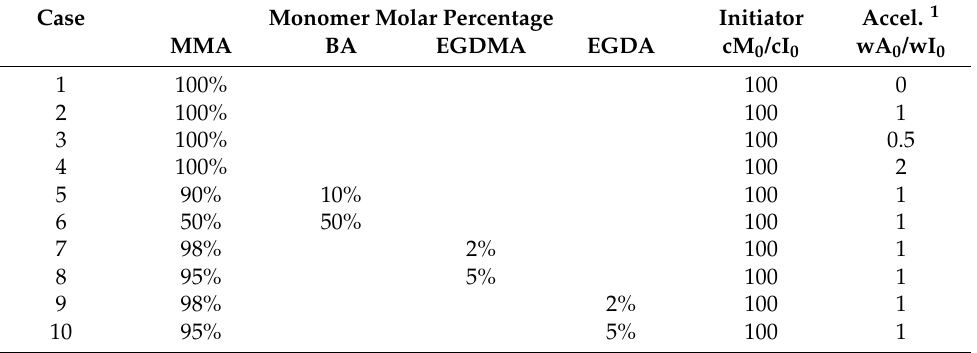
Table 1. (Co)formulation cases of reaction mixtures explored in the present work. Each case is described by the molar percentage composition of the (co)monomer solution, the molar concentration ratio of initiator to monomer (cI 0 /cM 0 ), and the mass ratio accelerator to initiator (wA 0 /wI 0 ). In all cases, except Case 1, the polymerization was started at room temperature; Case 1 has a starting temperature of 90 ◦